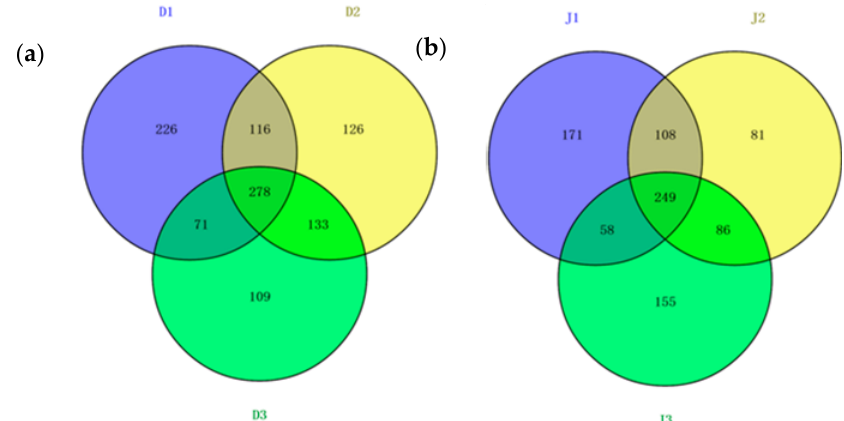
Figure 7. Shared OTUs of the archaeal 16S rRNA gene libraries of samples from ( a ) sewage creek; ( b ) industry creek.